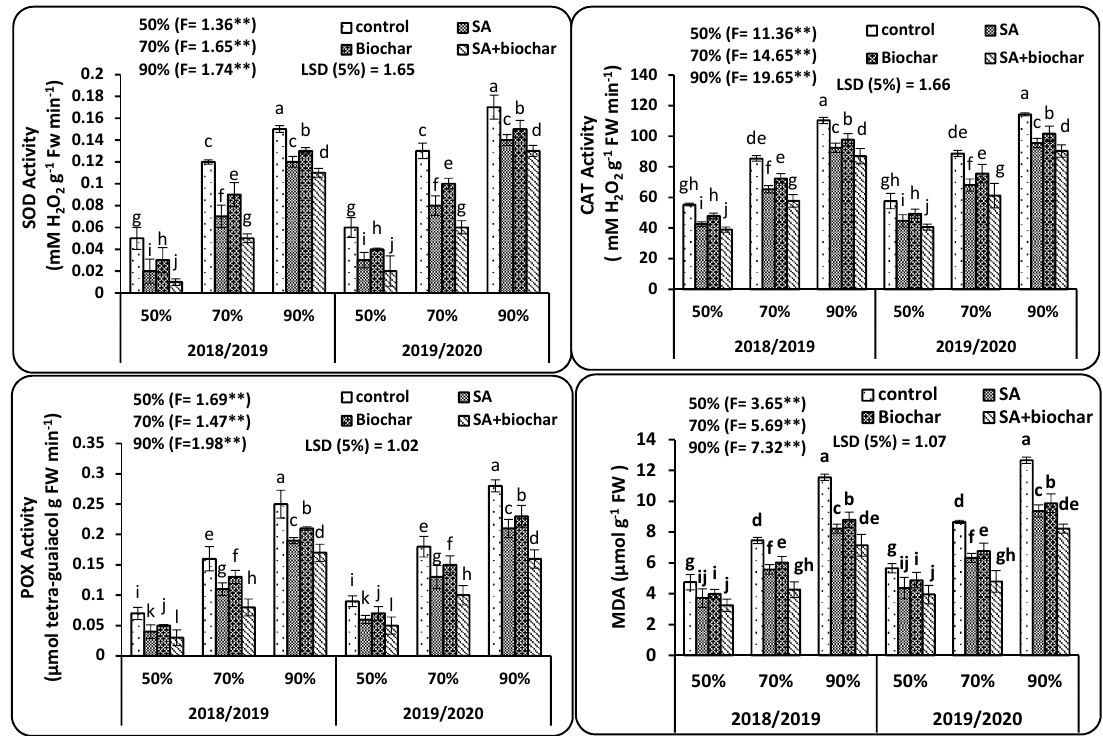
Figure 2. Superoxide dismutase (SOD), catalase (CAT), peroxidase (POX), and lipid peroxidation (MDA) of wheat leaves as treated by (control, salicylic acid, biochar, and SA + biochar) under di ff erent three irrigation conditions (50%, 70%, and 90% DAM) in saline sodic soil. Error bars indicate ± SE ( n = 3). SE indicates standard error. Mean values designed by the same letter in each column are not significant according to Tukey’s multiple range